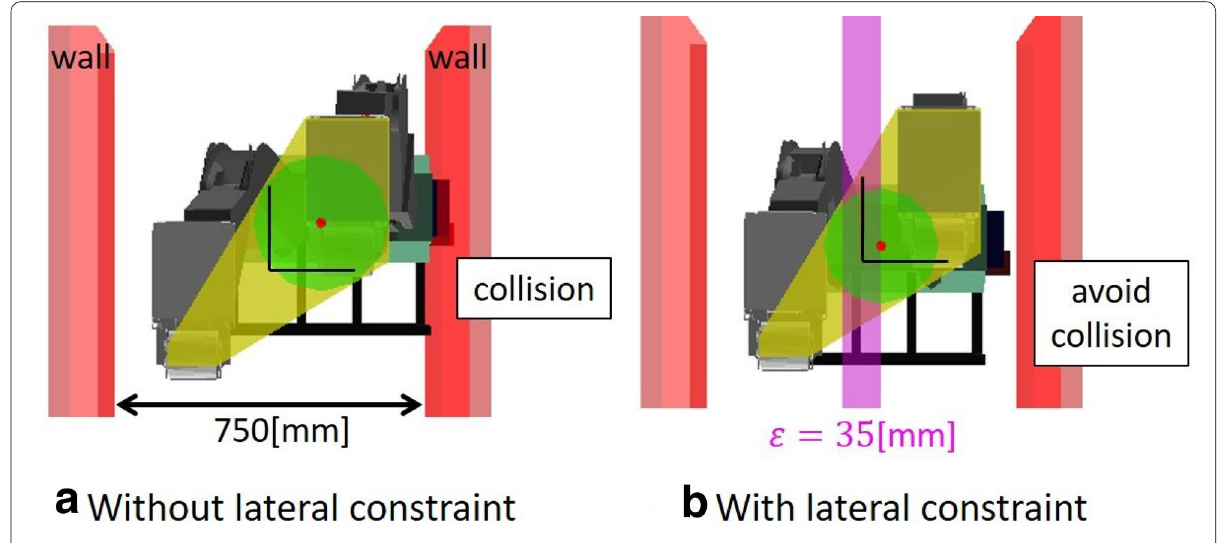
Fig. 7 Comparison at narrow space on Phase3